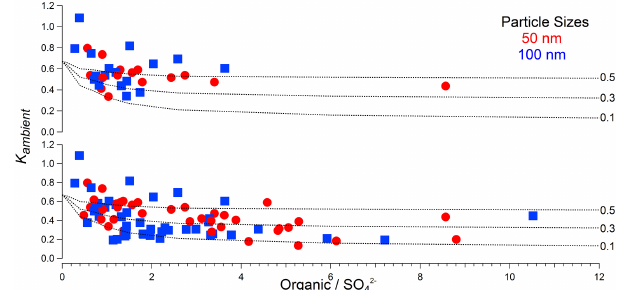
Figure 8. CCN-derived κ ambient of monodisperse ambient marine aerosol having dry mobility diameters of 50nm (red circles) and 100nm (blue squares) as a function of the organic to sulfate ratio measured by the ACSM from 13 and 18 to 20 August (top) and 13 to 23 August (bottom), PDT. Dotted black lines indicate calculated values of κ ambient from an assumed value for κ org (indicated at the right end of each line) and degree of sulfate neutralization taken from the MOUDI